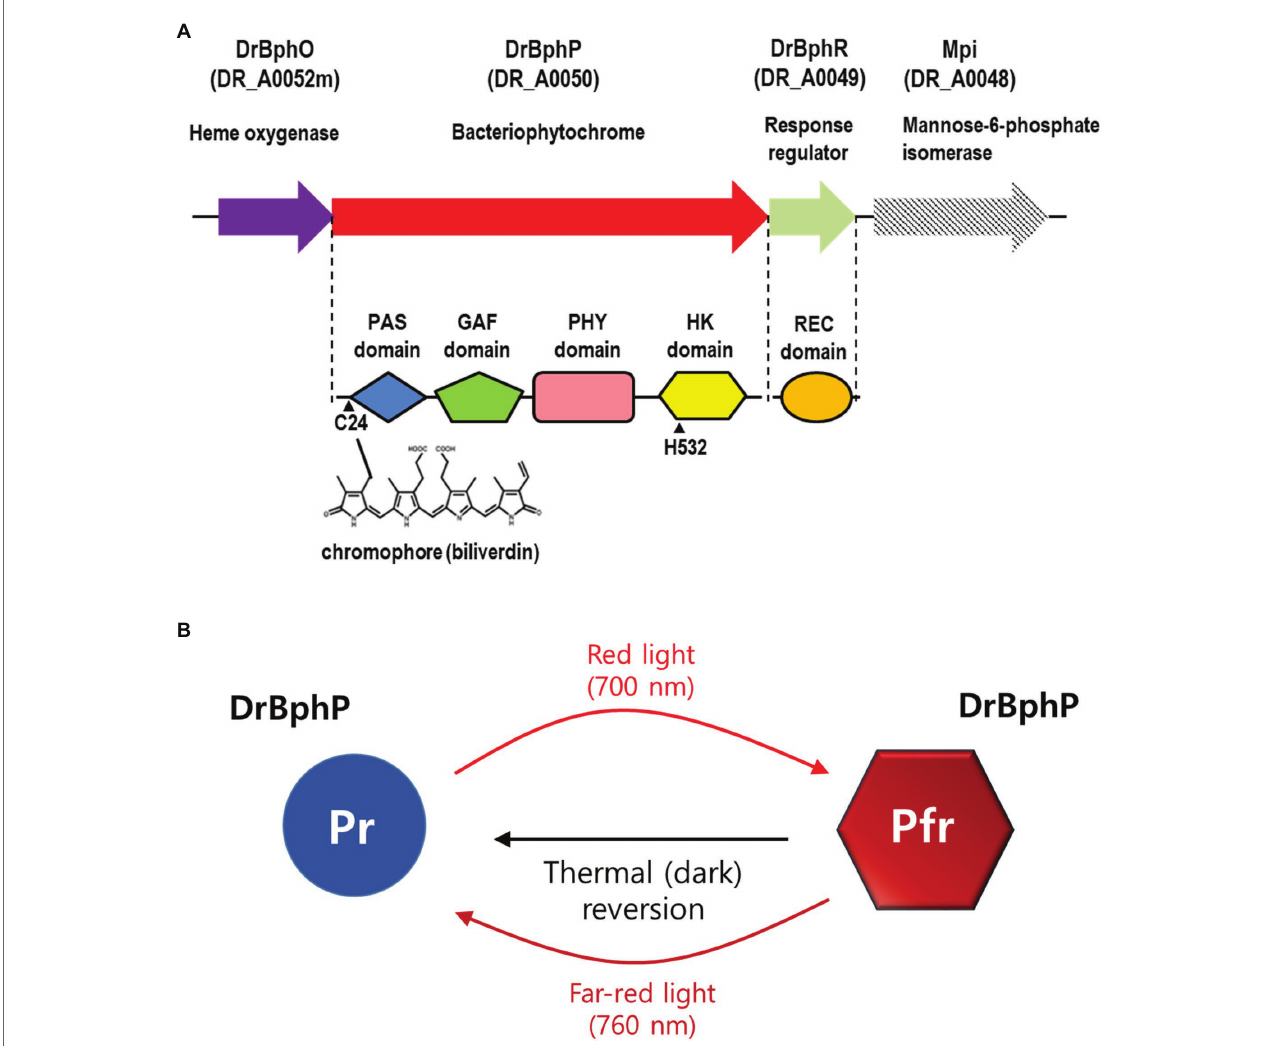
FIGURE 1 | Domain architecture and photocycle of Deinococcus radiodurans BphP (DrBphP). (A) Schematic representation of the D. radiodurans bph operon. Top line represents the bph operon and the downstream gene mpi . Each protein is shown with its corresponding locus tag. The Period/Arnt/Single-Minded (PAS), cGMP phosphodiesterase/adenylyl cyclase/FhlA (GAF), phytochrome region (PHY), and histidine kinase (HK) domains are linearly arranged in DrBphP. C24 that covalently binds biliverdin and H532 that interacts with DrBphR are indicated. (B) DrBphP photoconversion. Pr and Pfr denote the red and far-red light-absorbing conformations of DrBphP, respectively, which are reversible depending on light conditions. Pfr can also be converted to Pr in a light-independent process, referred to as thermal or dark